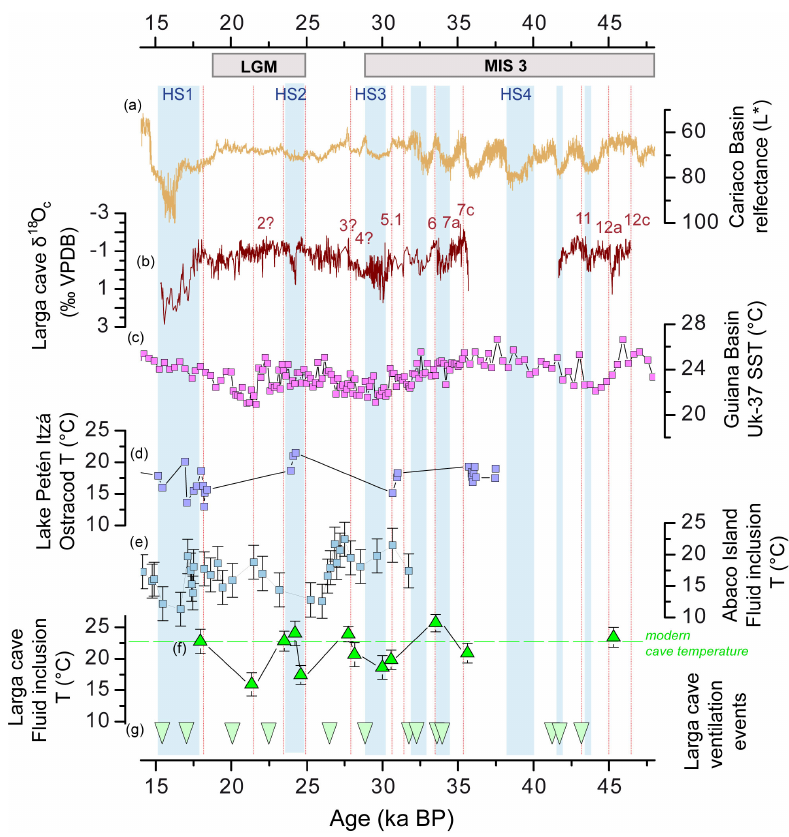
Figure 5. Palaeo-temperatures and the hydro-climate in the western tropical Atlantic region during the LGM and MIS2. From top to bottom: (a) Cariaco Basin reflectance record representing the mean meridional position of the ITCZ over northern South America (De- plazes et al., 2013); (b) speleothem PR-LA-1 δ 18 O c values from Warken et al. (2020), representing the local high-resolution hydro-climate; (c) Guiana Basin Uk37 SST reconstruction (Rama-Corredor et al., 2015); (d) Ostracod δ 18 O-derived temperature record from Lake Petén Itzá (Guatemala; Escobar et al., 2012); (e) speleothem fluid inclusion-based temperature reconstruction from the Bahamas (Arienzo et al., 2015); (f) fluid inclusion-derived temperatures from PR-LA-1 (this study). The horizontal dashed line indicates modern cave air temperatures at Larga Cave. (g) Green triangles indicate the timing of Larga Cave ventilation events as suggested by fluid inclusion stable isotopic com- position influenced by evaporation. In the tropical Atlantic, HS 1 to 4 and the Greenland stadials are associated with cold and dry conditions (light blue bars), and Greenland interstadials are associated with warmer and more humid climatic conditions (light red